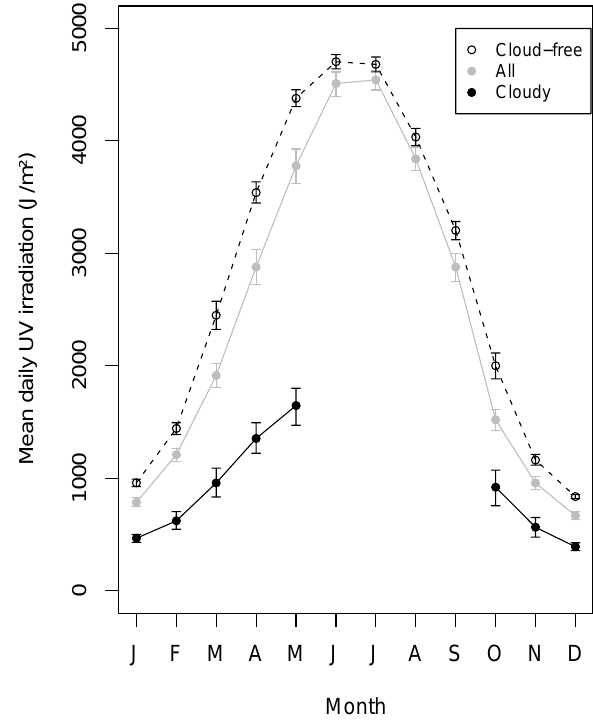
Fig. 3. Percentiles 0 (i.e. the minimum), 5, 25, 50 (i.e. the median), 75, 95, 100 (i.e. the maximum) of the distribution of daily UVER values for each calendar month.